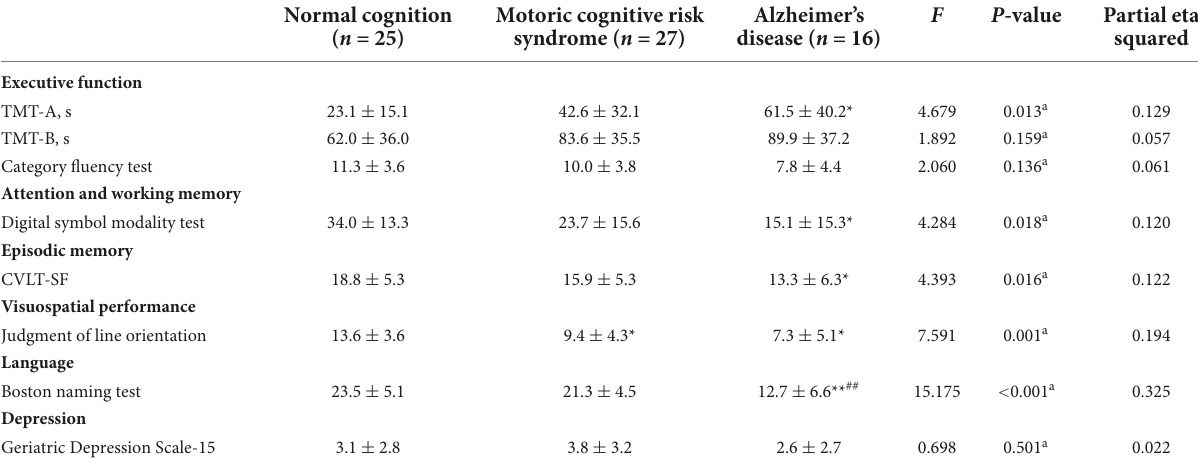
TABLE 2 Comparison of participants’ cognitive performance and physical function among the three groups ( n = 68).